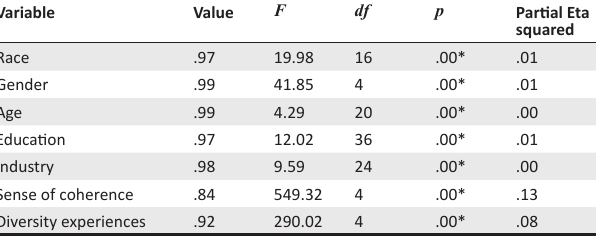
TABLE 4: Multivariate analysis of variance – differences in bullying levels based on socio-demographic characteristics, sense of coherence and